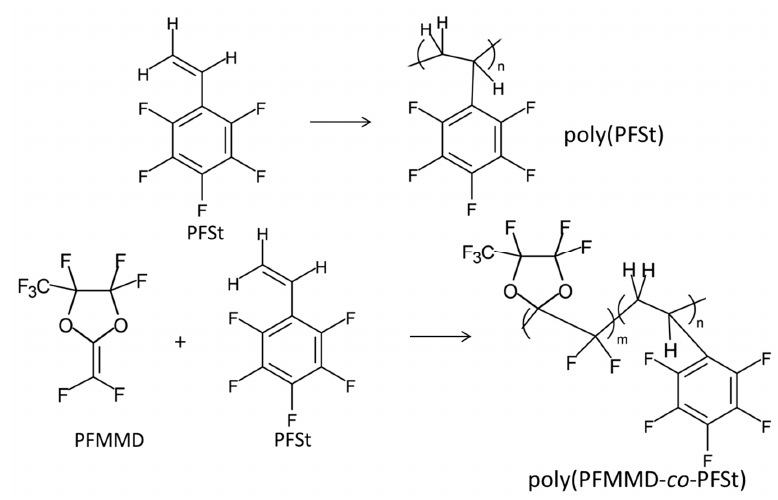
Figure 7. Chemical structures of polyPFSt and poly(PFMMD- co -PFSt).